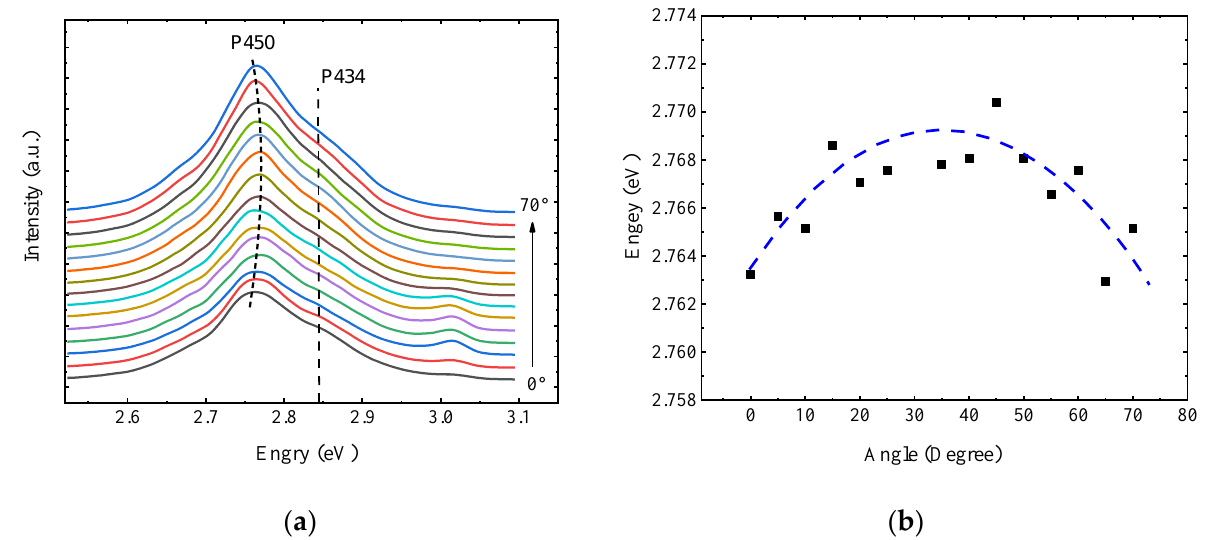
Figure 6. ( a ) The AR-PL spectra of θ =10° and ( b ) the experimental dispersion curve deduced from θ =10° AR-PL spectra.